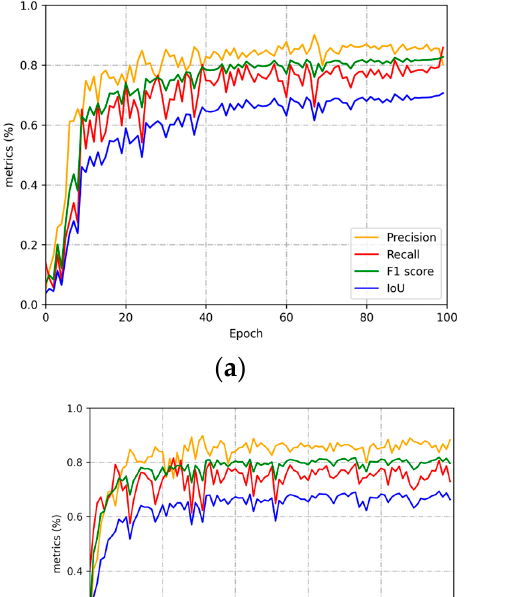
( d ) Figure 6. The metrics Precision, Recall, IoU, and F1 score as obtained from FPN for different back- bones: ( a ) vgg16, ( b ) resnet152, ( c ) densenet201, ( d ) inceptionv3. O r i g i n a l i m a g e G r o u n d T r u t h U - N e t - v gg 16